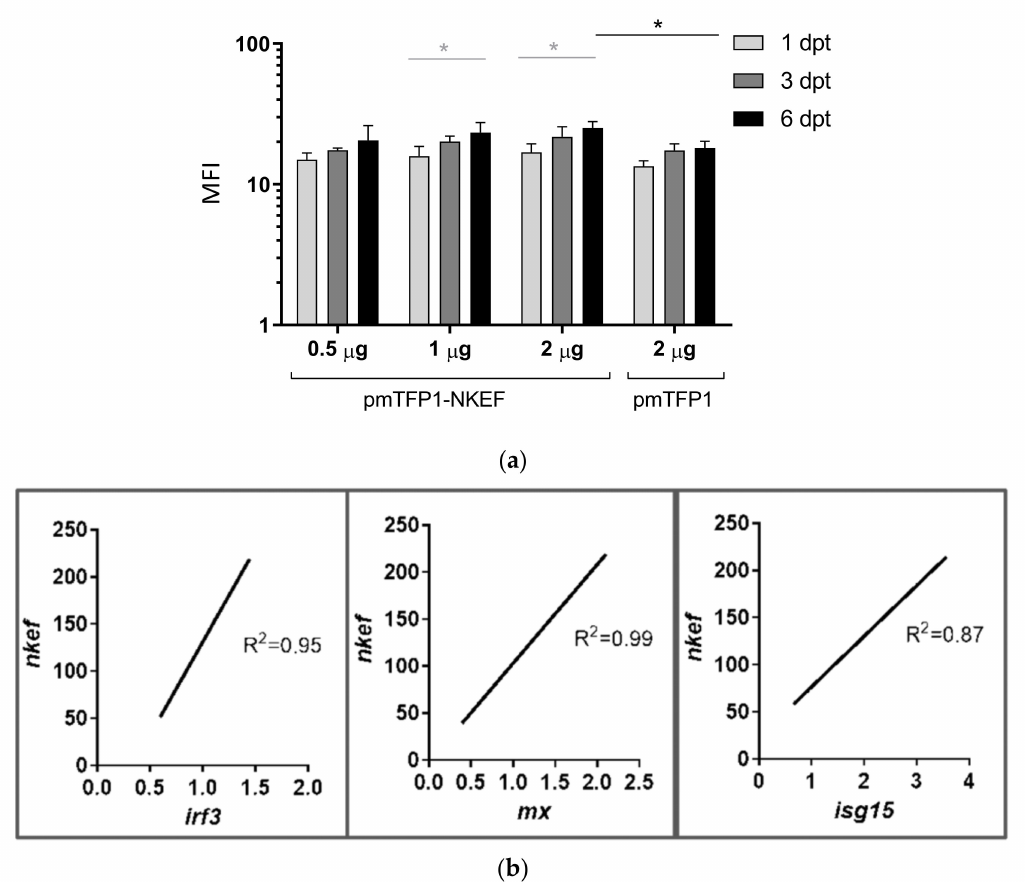
Figure 4. Time course of RBCs transfected with pmTFP1-NKEF. RBCs were electroporated with the plasmid pmTFP1-NKEF at different concentrations (0.5 µ g, 1 µ g, and 2 µ g). NKEF expression was monitored at various time points. ( a ) Evaluation of NKEF protein levels using flow cytometry via the fluorescence emitted by the NKEF-bound TFP1 protein. Data represent mean fluorescent intensity (MFI)(mean ± SD of n = 3 individuals). A two-way ANOVA and Tukey’s multiple comparisons test were performed for statistical analysis, between plasmid concentrations (black lines and asterisks) and times post- transfection (gray lines and asterisks). * indicates p -value < 0.05. ( b ) Analysis of the IFN1-related genes irf3 , mx , and isg15 modulation in RBCs transfected with the plasmid pmTFP1-NKEF. Gene expression was evaluated by RT-qPCR. Linear regression was calculated between nkef gene expression and interferon stimulated genes irf3 , mx , and isg15 in pmTFP1-NKEF transfected RBCs (with 2 µ g of plasmid and 3 dpt). Gene expression was normalized to pmTFP1 transfected RBCs. The endogenous gene control used was om-ef1 α . Data are displayed as a linear regression line (R 2 : coefficient of correlation), n = 3